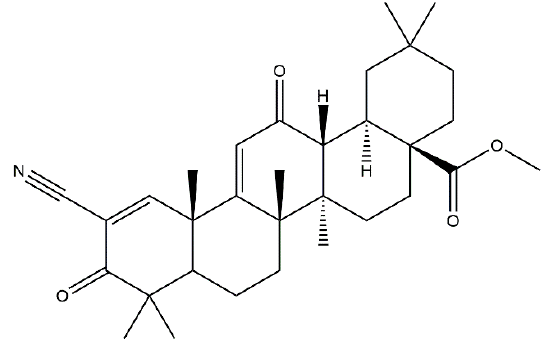
Figure 2. The chemical structure of bardoxolone methyl.